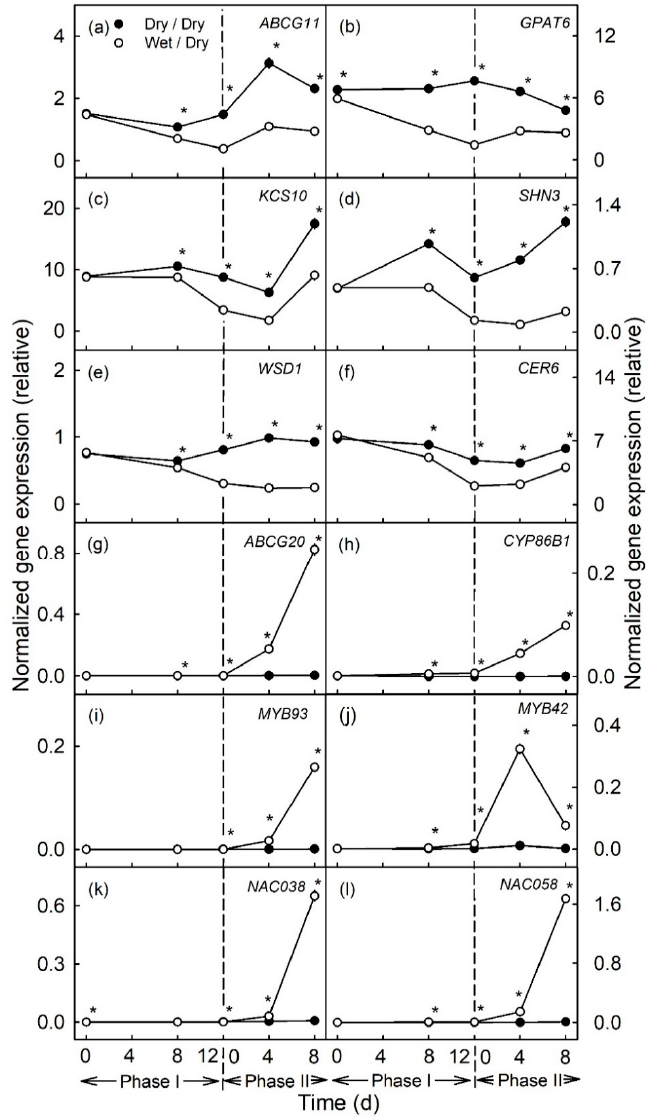
Figure 2. Time courses of expression of genes related to cutin and wax synthesis ( a – f ) and to suberin and lignin synthesis ( g – l ) of apple fruit skin during (Phase I) of exposure to moisture and after exposure to moisture was discontinued (Phase II). During Phase I, a patch of the fruit skin was exposed to moisture for 12 d beginning at 31 days after full bloom (DAFB) (wet). During the subsequent Phase II, moisture was removed, and the patch was exposed to the atmosphere (dry). Moisture-exposed patches of the fruit skin are referred to as wet/dry, unexposed control patches as dry/dry. The end of moisture exposure is indicated by the vertical dashed line. The expression values are means ± SE of three independent biological replicates comprising ten fruit each. The ‘*’ indicates significant differences between dry/dry and wet/dry at p ≤ 0.05 (Student’s t -test).